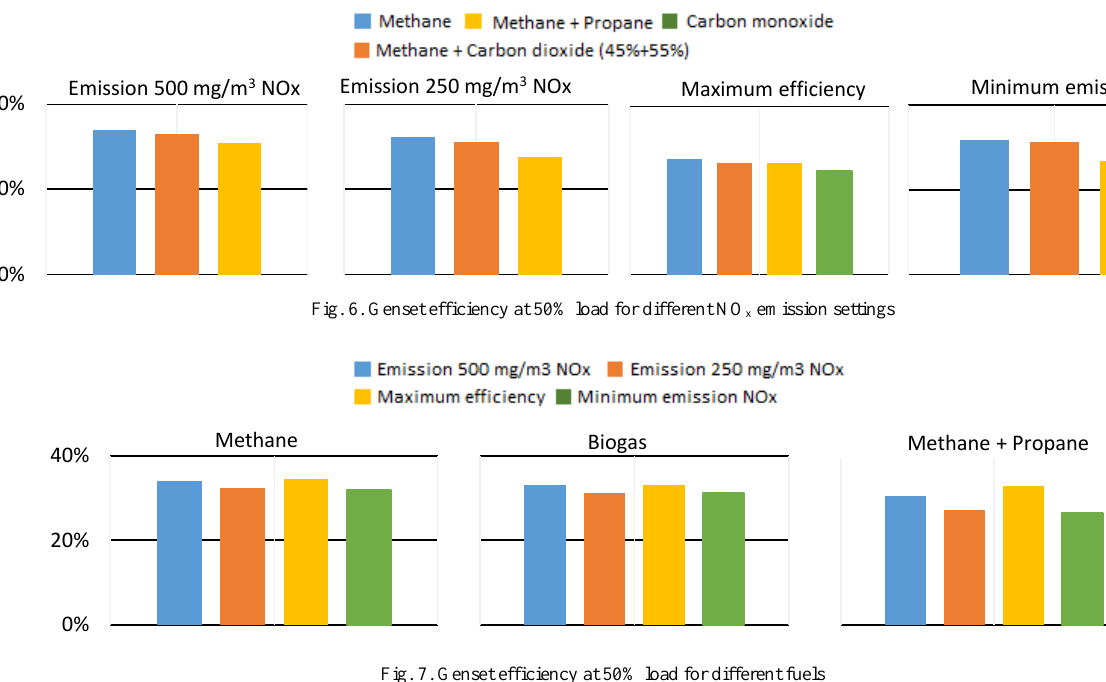
Fig. 7. Genset efficiency at 50% load for different